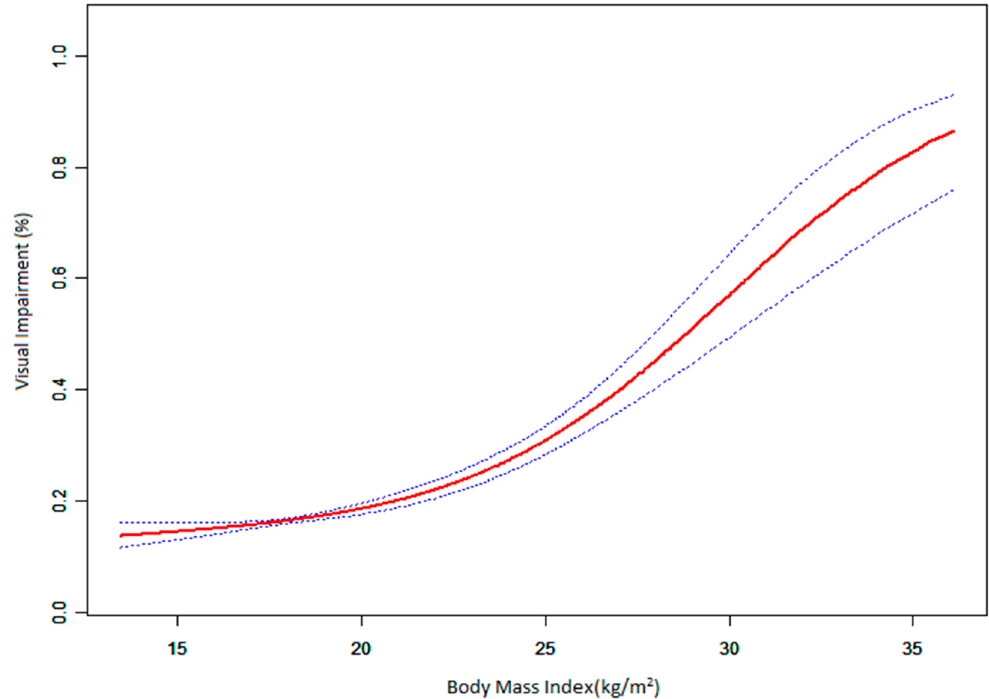
Figure 2. The dose–response relationship of BMI and VI . Adjusted for age, sex, level,